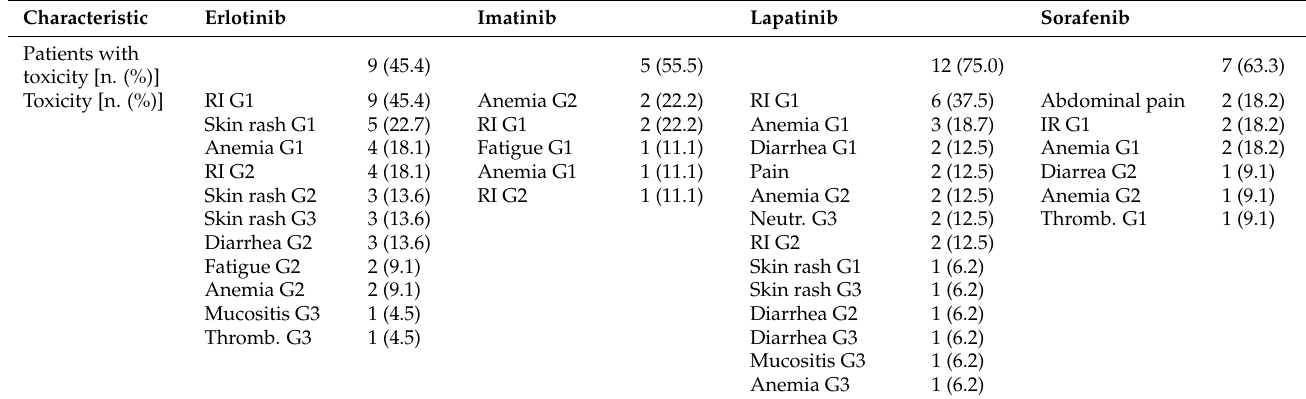
Table 4. Incidence of toxicity.